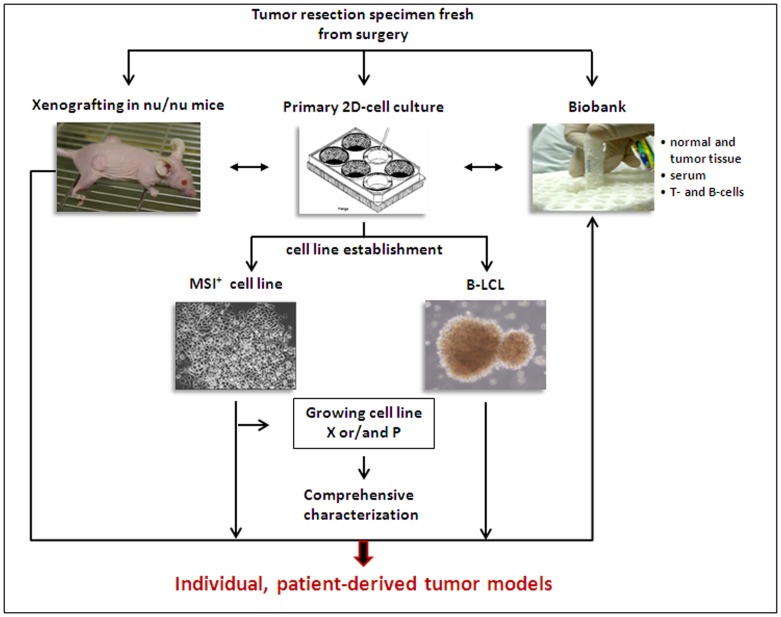
Scheme of the experimental protocol for cell line establishment either fresh from surgery specimens ( = patient-derived cell line) of following xenografting in nu/nu mice ( = xenopatient-derived cell line).Established cell lines were comprehensively characterized and routinely cyropreserved together with xenograft-tissue, immune cells, serum, and normal as well as primary tumor tissue in a biobank. This procedure leads to generation of individualized, patient-derived tumor models available for functional analyses.